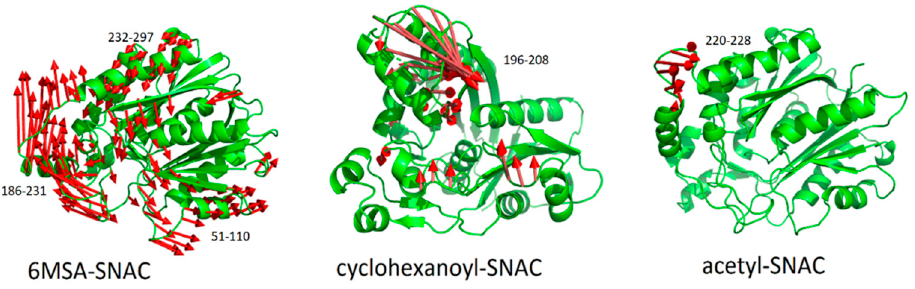
Figure 8. PCA analysis showing the magnitude of dominant movements of protein regions for 6MSA-SNAC, acetyl-SNAC and cyclohexonyl-SNAC complexes calculated from simulated trajec- tories.